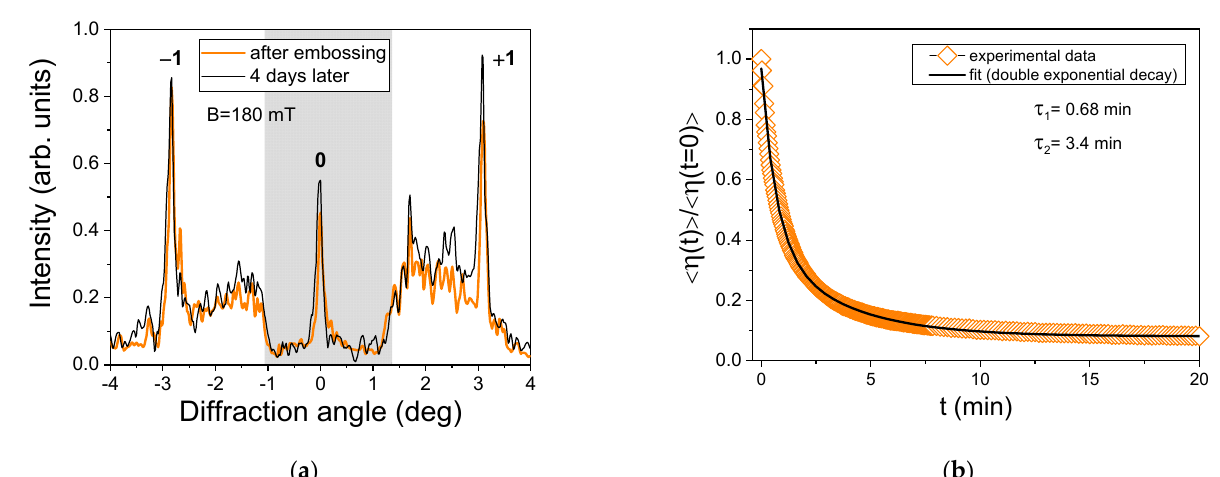
Figure 3. ( a ) Transversal profile of the far ‐ field optical diffraction pattern recorded a few minutes (thick orange line) and four days (thin black line) after the embossing process in sample M3. To resolve more details, the optical signal in the central region (gray ‐ shaded area) was attenuated for a factor of 5 with respect to other regions. The sample was constantly kept in the magnetic field B = 180 mT. ( b ) Time dependence of normalized diffraction efficiency < 𝜂 ( t )>/< 𝜂 ( t = 0)> after fast removal of the magnet. The solid line is a fit to a two ‐ exponential decay function with decay times τ 1 = 0.68 min and τ 2 = 3.4 min.